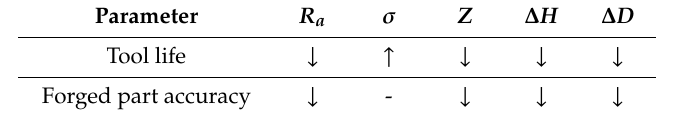
Table 4. E ff ects of increase in analyzed parameters on forging tool life and forged part